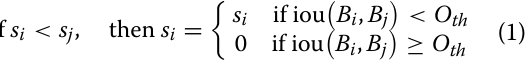
Fig. 5 Overview of the proposed method